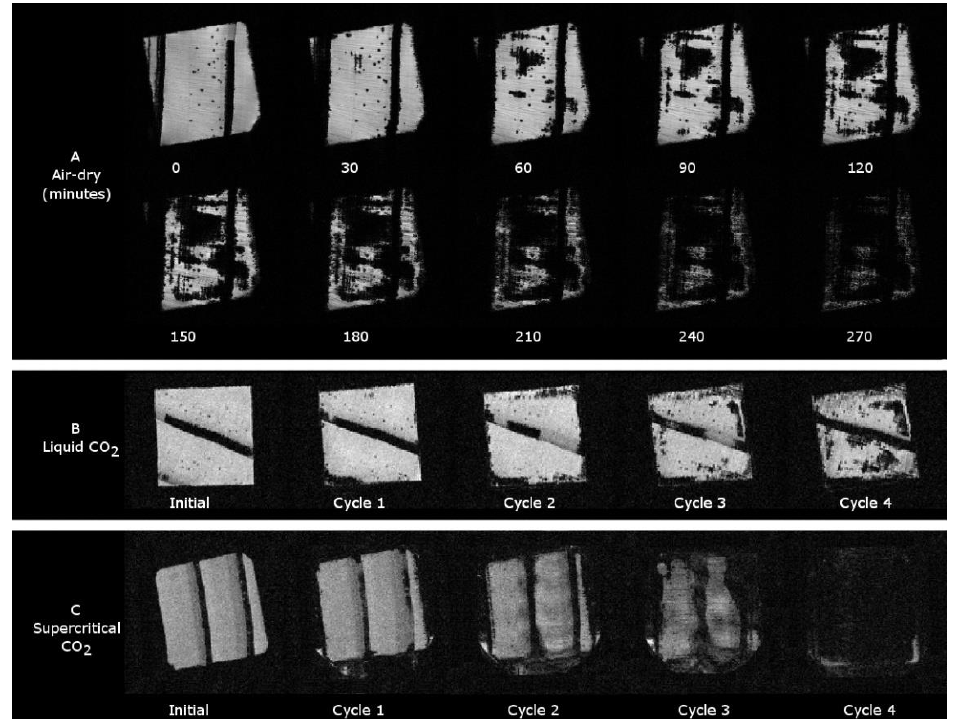
Figure 3. 1 H magnetic resonance images showing radiata pine sapwood specimens undergoing ( A ), conventional drying by water evaporation, and ( B ), cell water displacement by carbon dioxide delivered to the high-pressure “autoclave” by liquid delivery where in the cell at 20 °C, carbon dioxide exists in the gas phase in equilibrium with the liquid phase at 5 MPa, and it was cycled between this pressure and 0.1 MPa, and ( C ), cell water displacement with carbon dioxide undergoing cyclical phase change between supercritical fluid up to 20 MPa, 50 °C, and gas at 0.1 MPa [33] (with permission from de Gruyter).